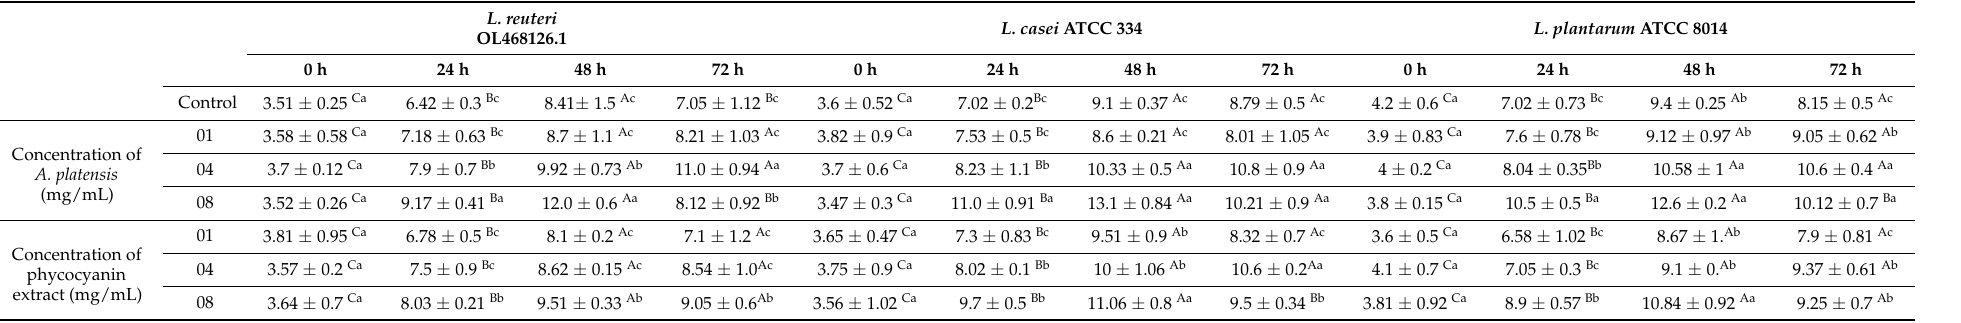
Table 4. Growth kinetics of the tested Lactobacillus strains (log 10 CFU/mL) supplemented with A. platensis or phycocyanin